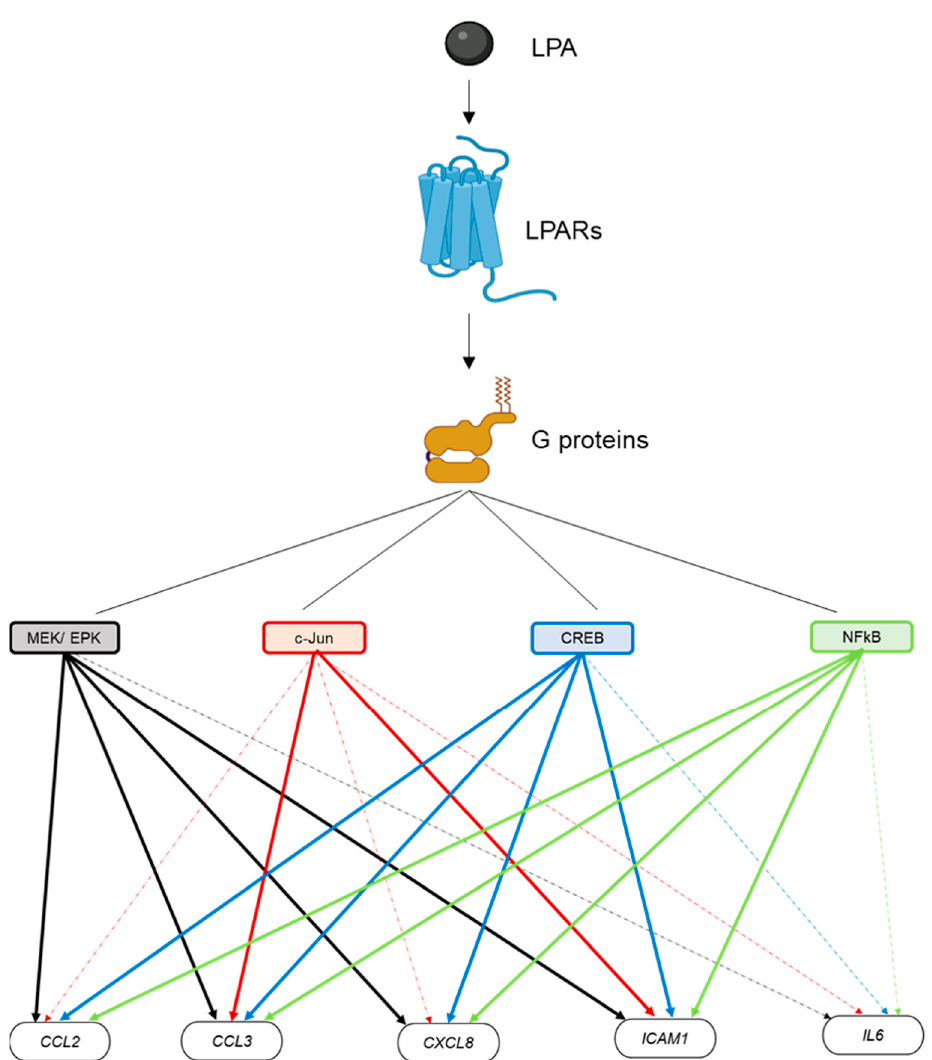
Figure 9. Graphical depiction of the LPA-induced signaling pathways in HKC-8 cells. LPA binds to the LPARs, which activate G proteins and the signal progresses to secondary signaling hubs, such as MEK/ERK or transcription factors c-JUN, CREB1, and NF κ B. MEK/ERK, CREB1, and NF κ B co-activate CCL2 , CCL3 , CXCL8 (IL-8), and ICAM1 expression. C-JUN activates only CCL3 and ICAM1 expression. Solid colored lines show connections that are derived from our results. Connections depicted with dashed lines are drawn from the literature and are not verified from our data. Created with BioRender.com, accessed on 1 June 2022.